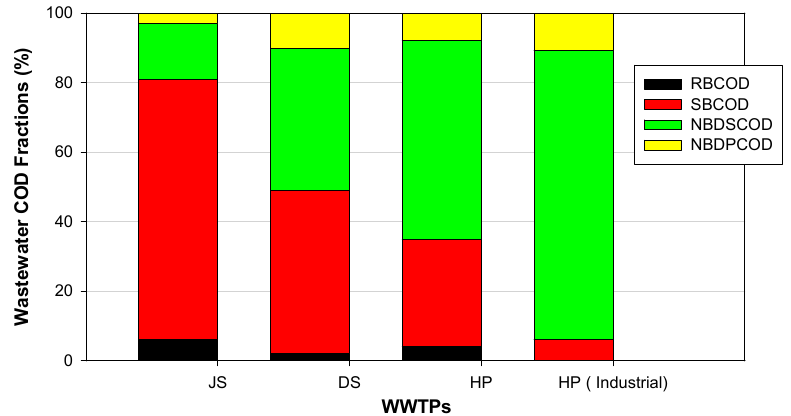
Figure 3. Estimated COD fractions of the influent wastewaters in Jisan wastewater treatment plant (JS WWTP), Dalseocheon wastewater treatment plant (DS WWTP), Hyunpoong wastewater treatment plant (HP WWTP), and the industrial discharge from pulp mill factories in the HP WWTP’s catchment area. The fractions in the figures represent the average values of the two measurement campaigns.